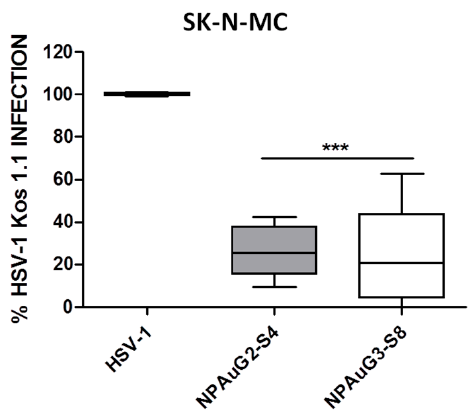
Figure 4. Cellular protection mediated by NPAus. SK-N-MC cell line was exposed to the maximum non-toxic concentration for 1 h. SK-N-MC cells were washed to eliminate the NPs and infected at MOI 1 for 1 h. Data represent median and interquartile range ± SD from three independent experiments performed by duplicate. ***: p < 0,001; **: p < 0.01; *: p < 0,05. HSV-1 infection control at MOI 1.